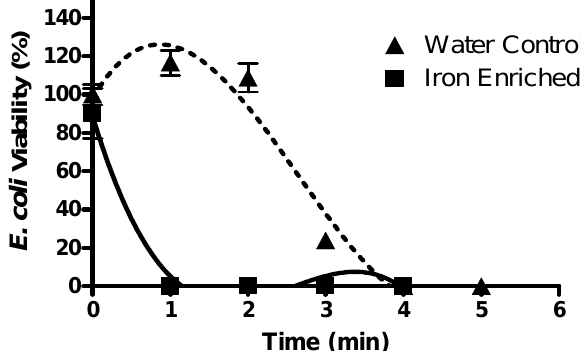
Figure 6: Effect of iron ions on microwave disinfection of E. coli. Illustrates the effect that iron ions (solid line) have on the deactivation of E. coli (n = 10) during microwave heating compared to a distilled water control (dotted